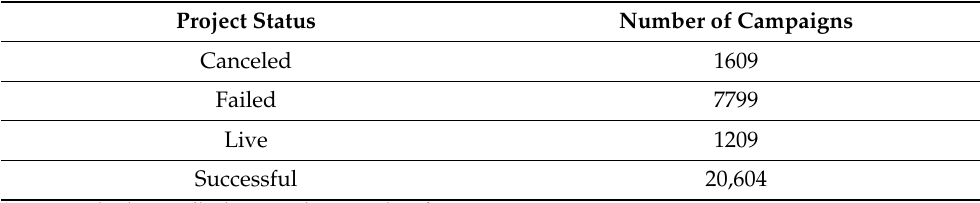
Table 1. Breakdown of projects according to their